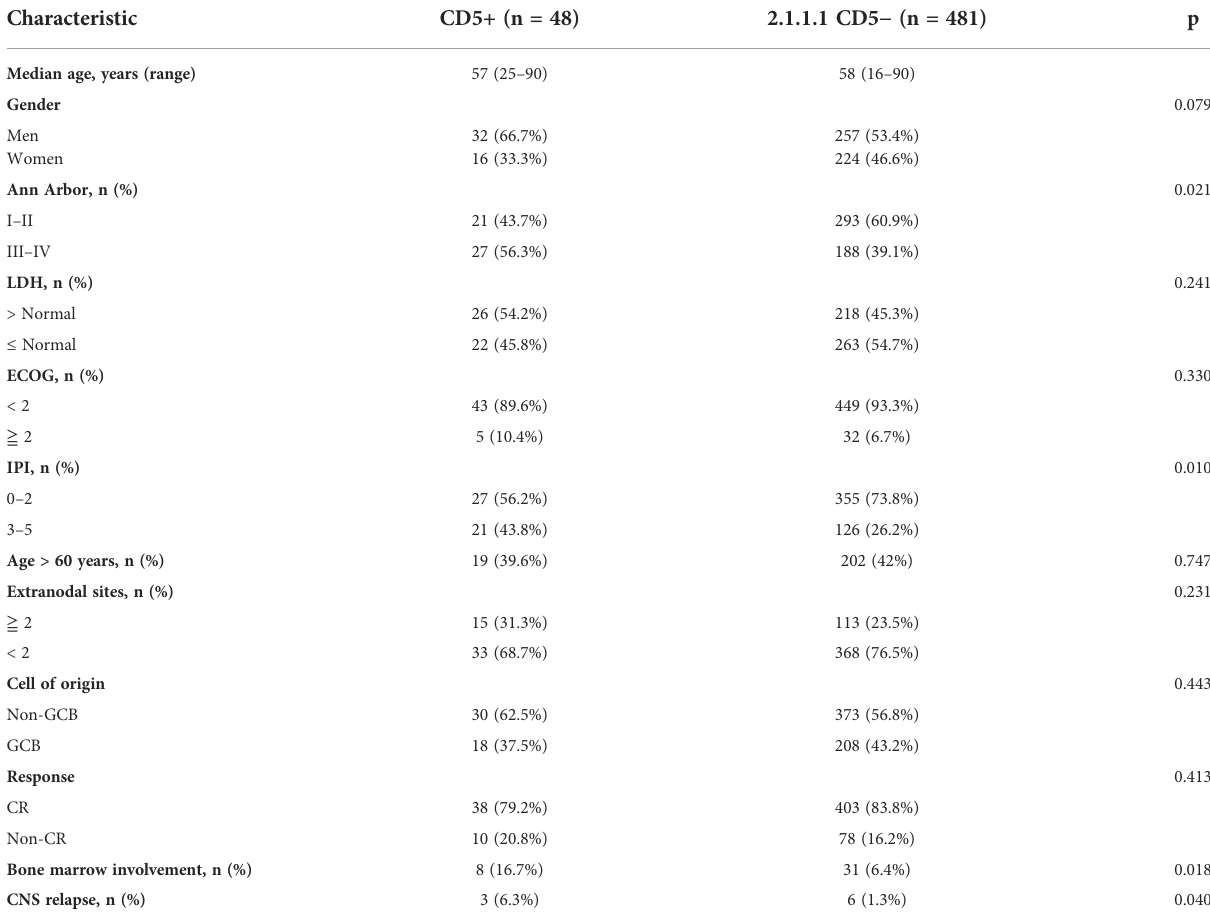
TABLE 1 Clinical characteristics of CD5+ and CD5 − non-DE DLBCL patients. .